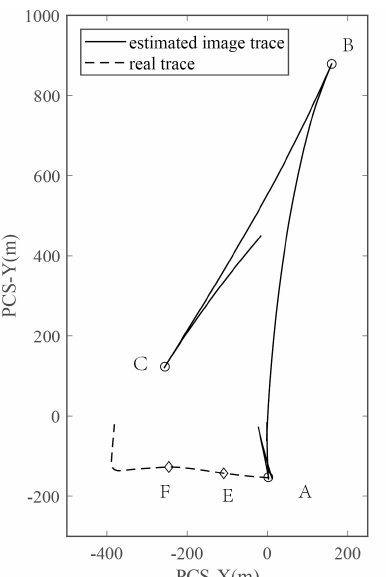
Figure 21. Target’s real trace and corresponding image trace calculated in the ground